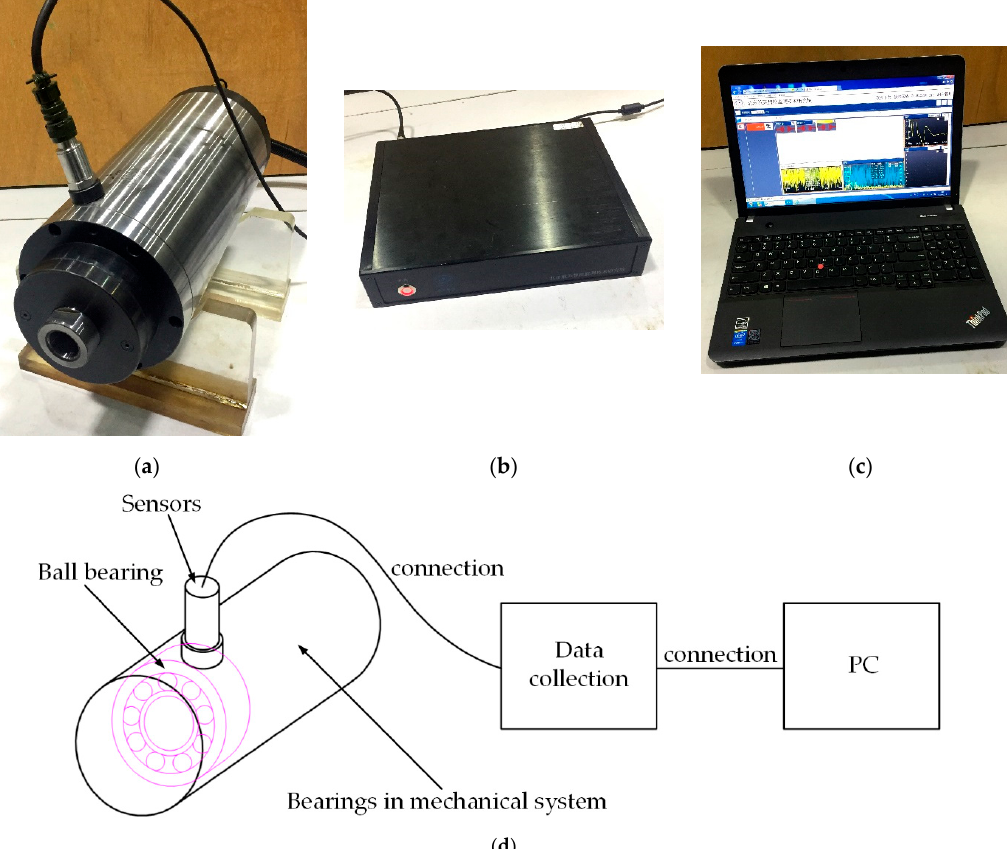
Figure 8. The photo and schematic diagram of the measurement and applications: ( a ) Photo of sensors and bearings in mechanical system; ( b ) photo of data collection; ( c ) photo of PC; ( d ) schematic diagram of measurements.